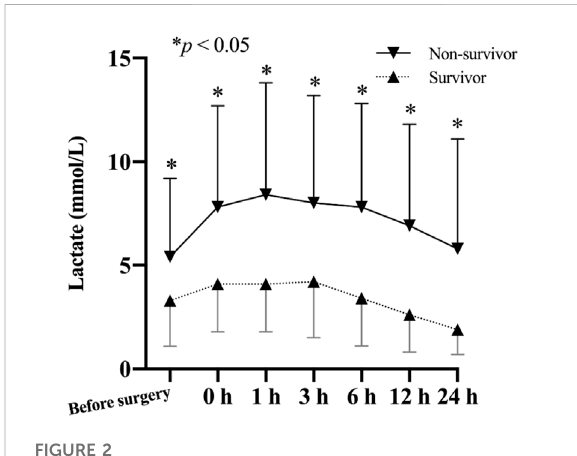
FIGURE 2 Comparison of lactate levels (mean and standard deviation) of patients from the non-survivor group and the survivor group based on their 30-day